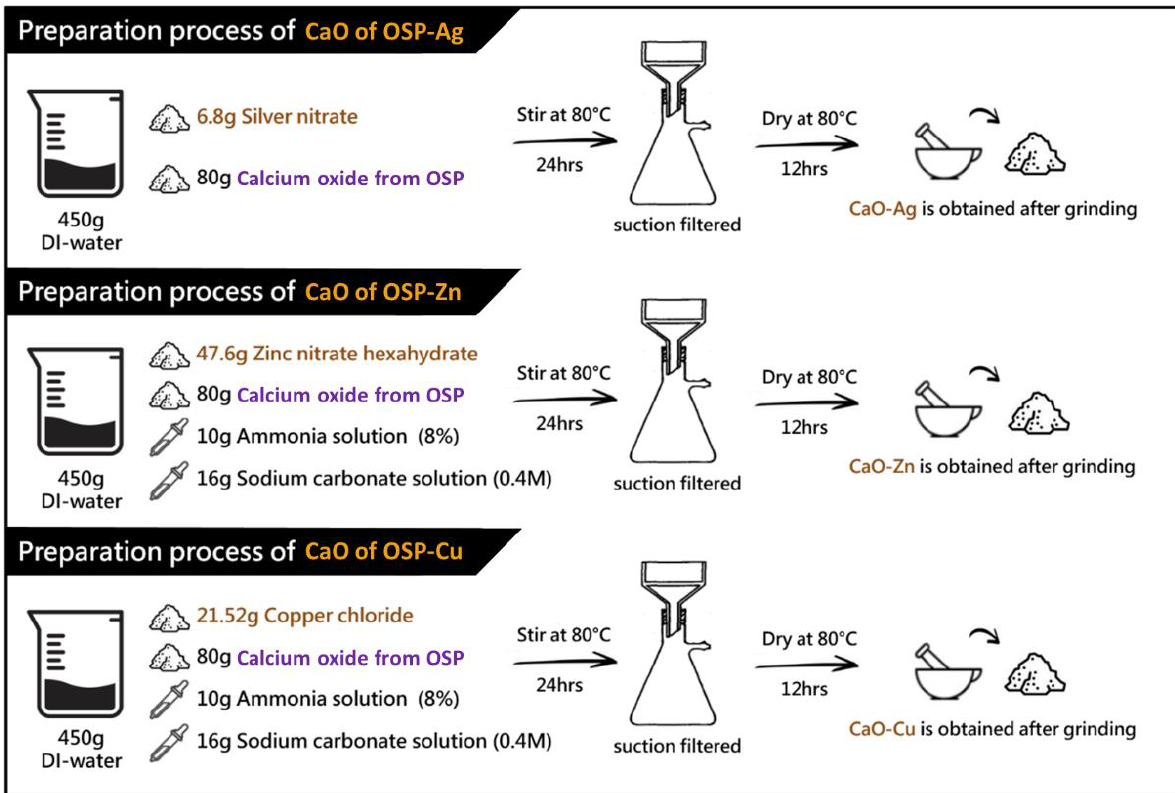
Figure 1. Schematic diagram of the preparation process of metal ion (Me)-containing calcium oxide from oyster shell powder (OSP) .